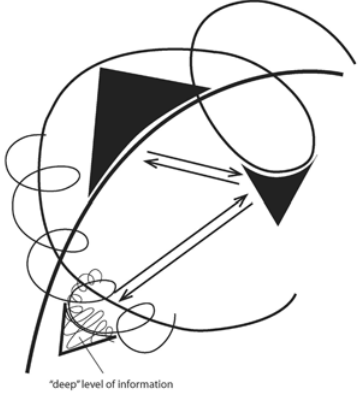
FIGURE 4. Illustration of information transmitting interactions. Interactions (arrows) are transferred between elements of same level, and between different levels (“the information-transferring power of the fractal”).